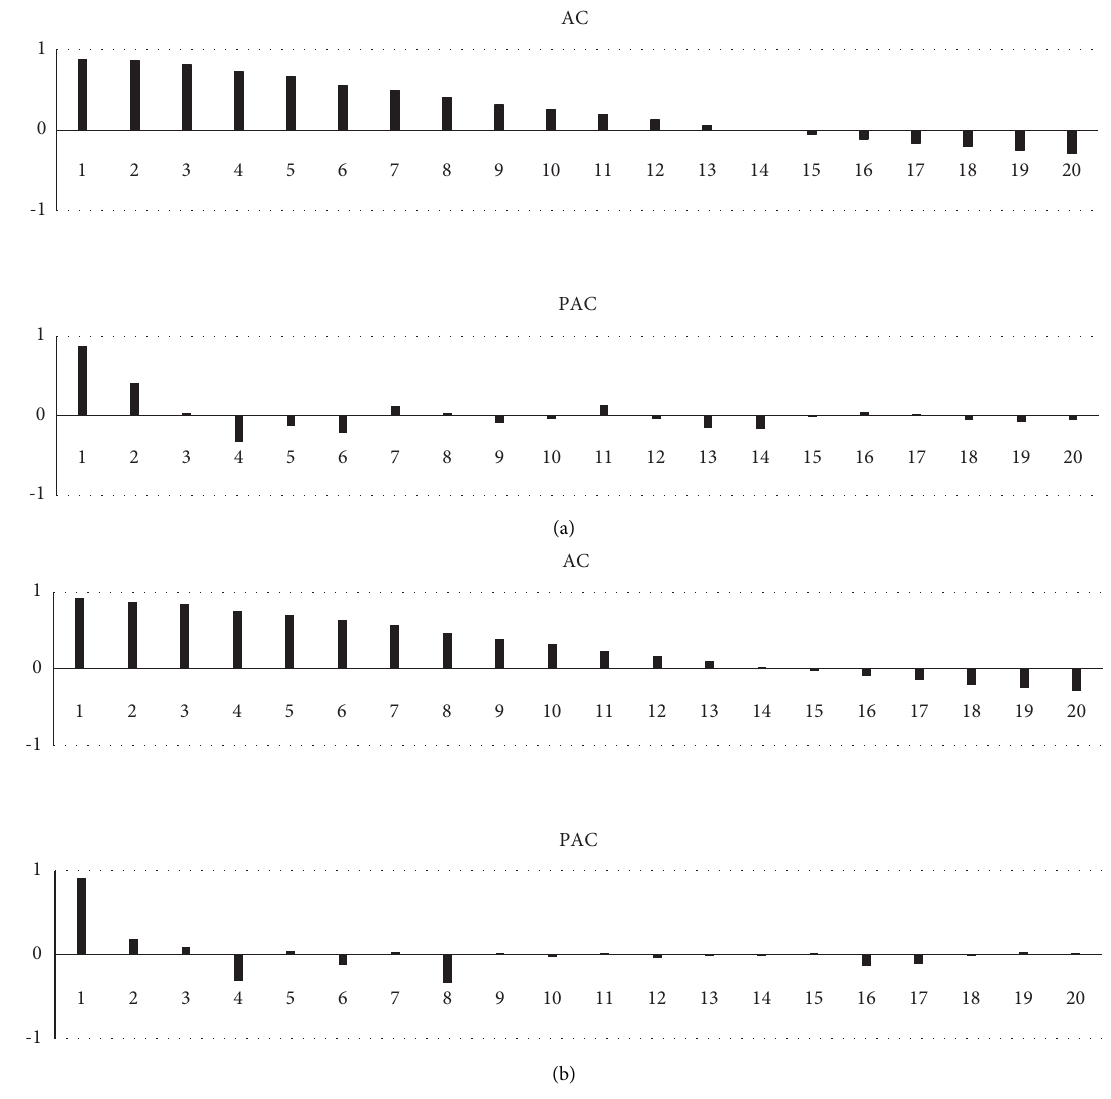
Figure 3: Correlogram of LIMPIRN and LEXPIRN with 20 lags at the level. Source: estimations based on the data extracted from the IMF direction of trade statistics [23]. (a) Natural logarithm of China’s import from Iran (LIMPIRN). (b) Natural logarithm of China’s export to Iran